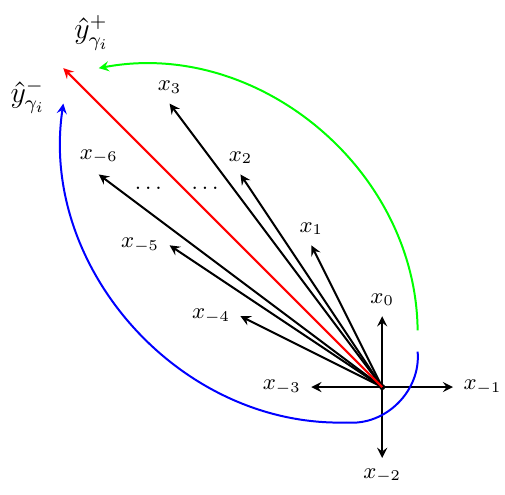
Figure 6. g -vector fan associated with the A 1 , 1 cluster algebra. There are two paths to cones asymptotically close to the limiting ray (red), which are green and blue respectively. The green path leads to the ˆ y + expressions while taking the blue path leads to the ˆ y − γ i